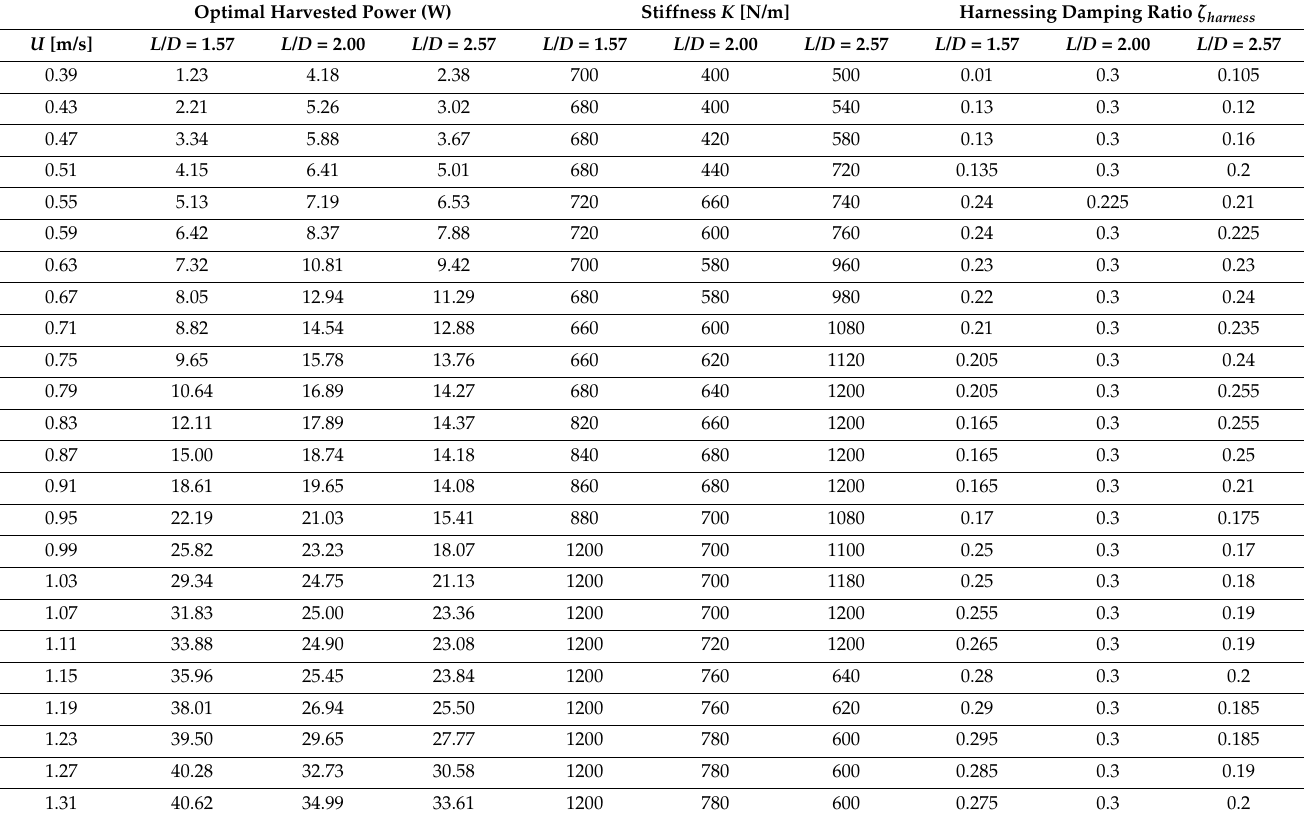
Table A1. Parameters for optimal harnessed power for two tandem cylinders with spacing: L / D = 1.57, 2.00 and 2.57. Optimal Harvested Power (W) Stiffness K [N/m] Harnessing Damping Ratio ζ